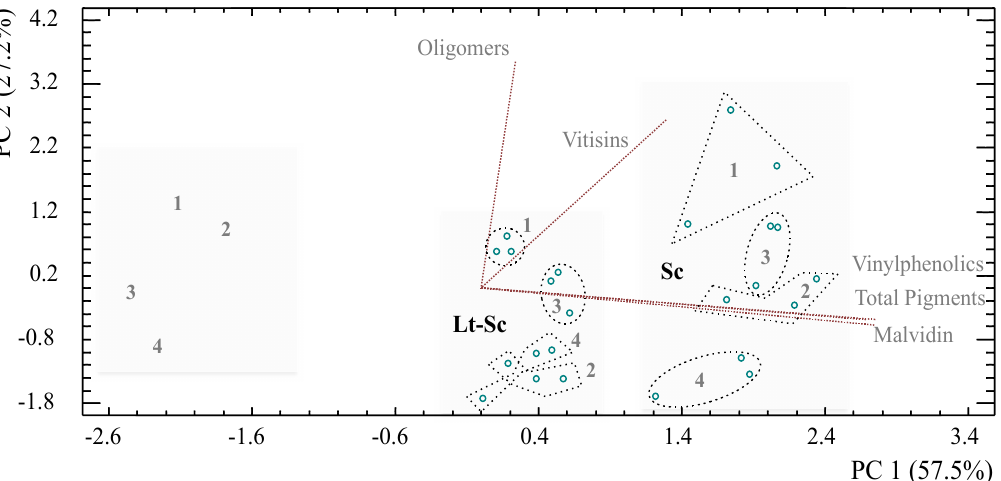
Figure 2. Principal Component Analysis (PCA) for pigments determination in experimental trials. The clusters identified correspond to the fermentative yeasts used (block font). The numbers refer to each of the four treatments assessed: (1) CAT; (2) PB2; (3) PC1, and; (4) PA2.